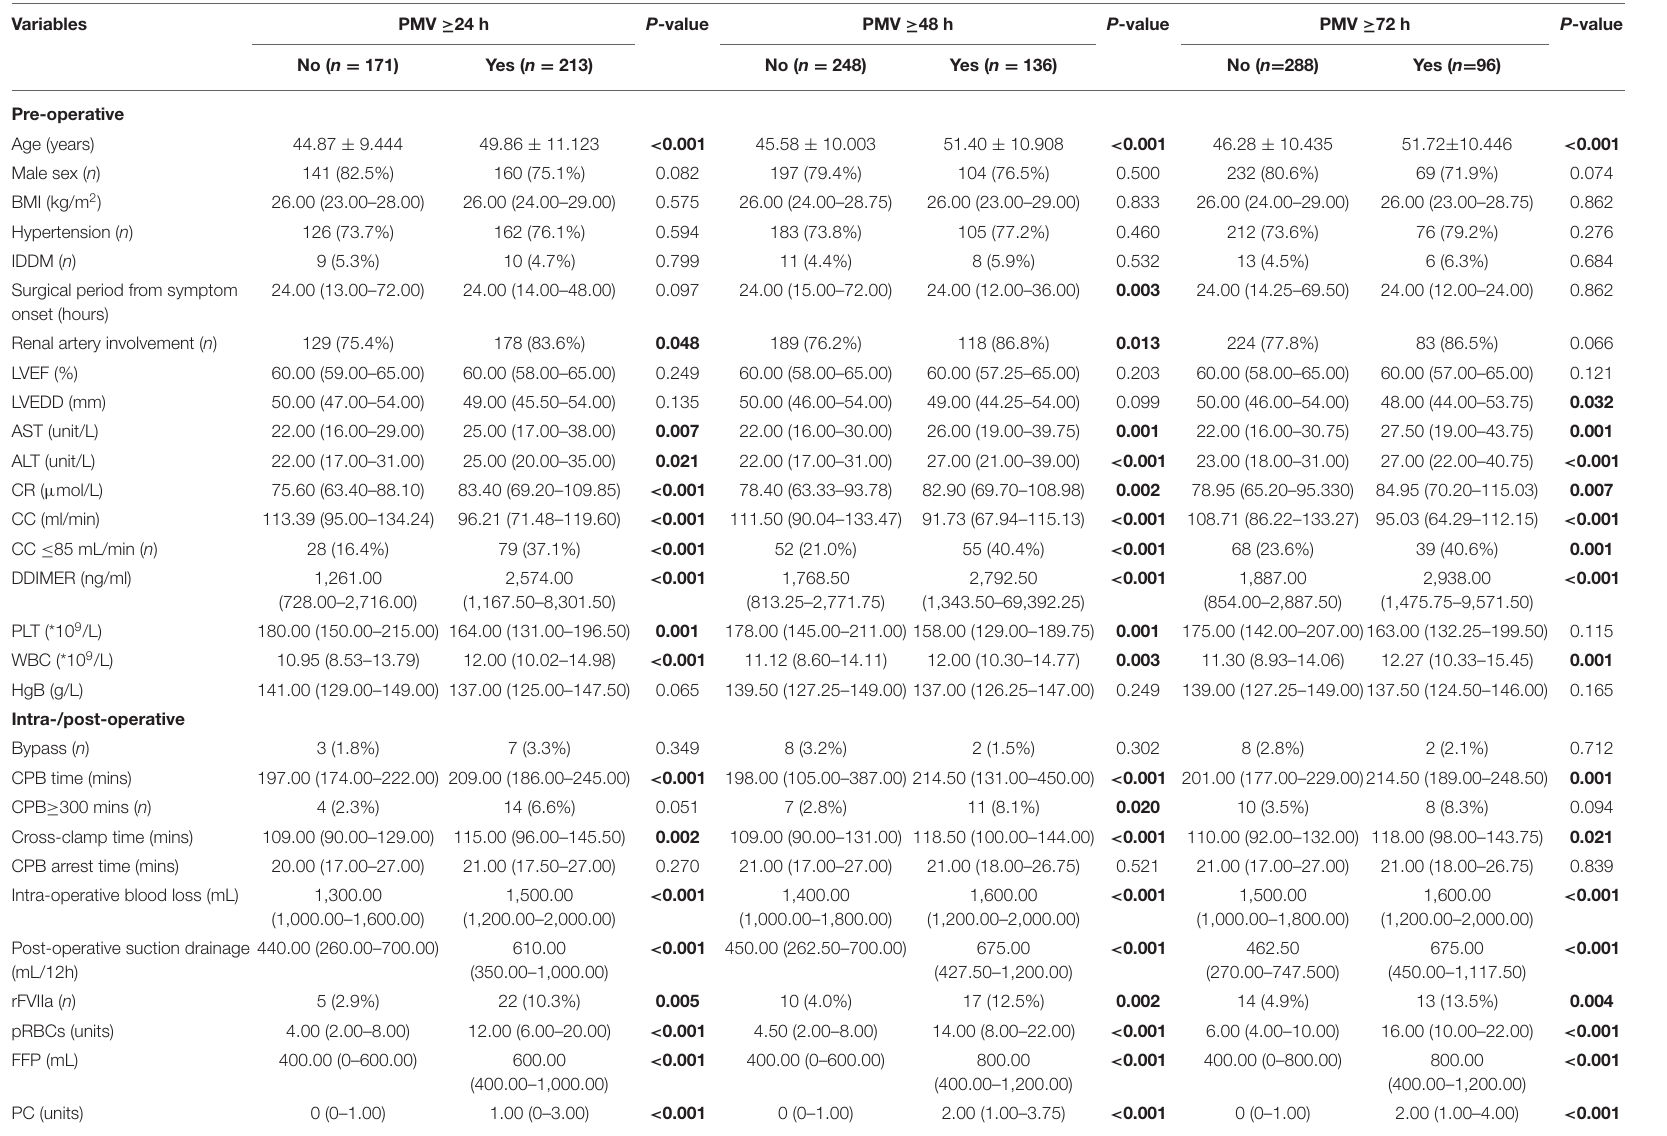
TABLE 4 | Baseline characteristics and perioperative data in three PMV